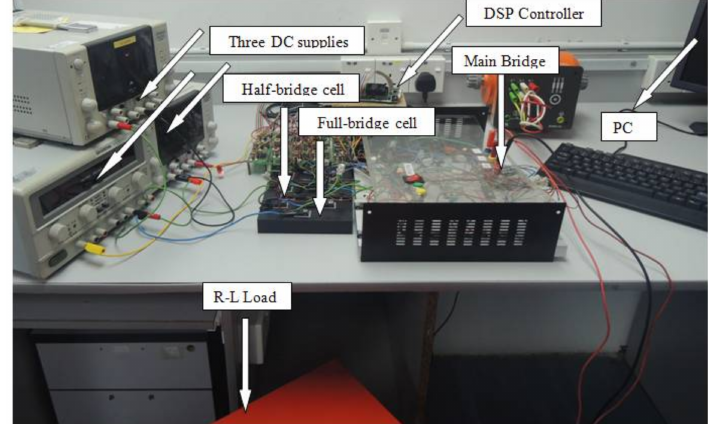
Figure 8. Laboratory setup of the hardware prototype.